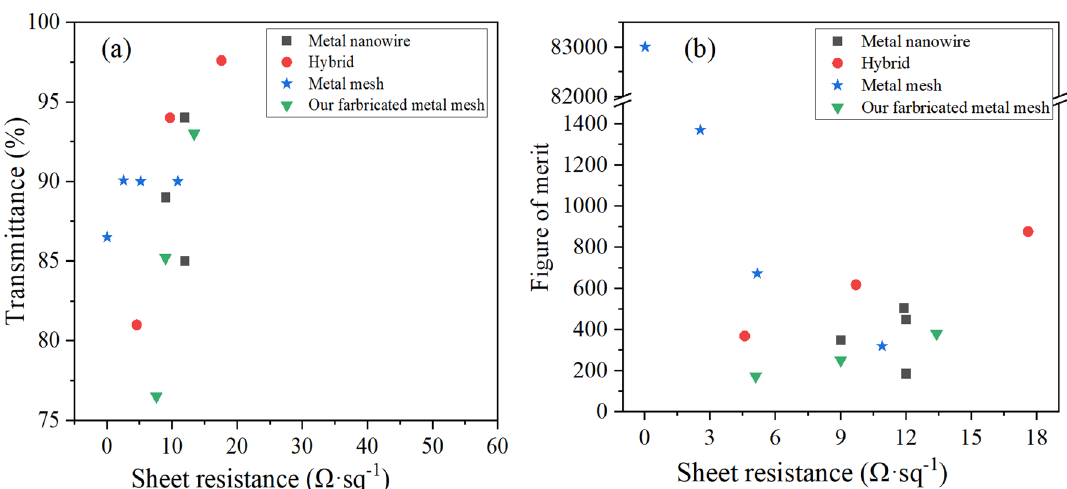
Figure 6. Performances of the flexible TCFs. ( a ) Transmittance versus sheet resistance data of the metallic network in comparison with previous studies (metallic wire 13,44–46 , metallic network 9,25,33,47 , hybrid 48–50 ), ( b ) Comparison of the figure of merit